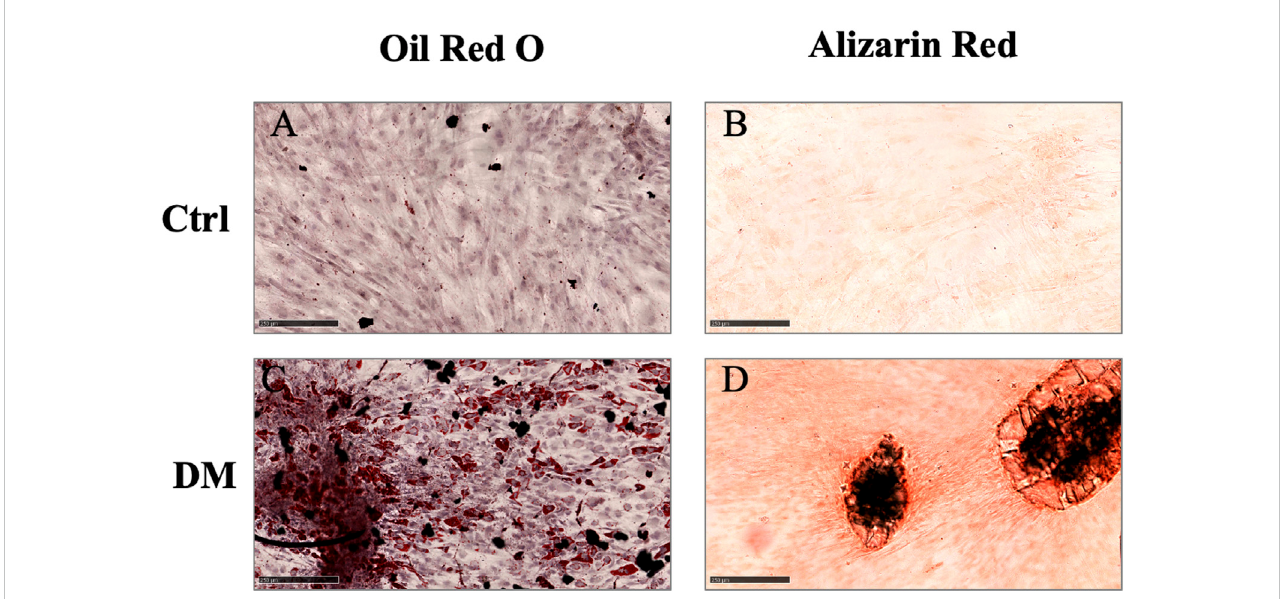
FIGURE 3 Multilineage differentiation assay. (A – C) Oil Red O staining of cells differentiated toward adipocytes (DM), compared to control cells cultured for the same days in DMEM with 10% FBS (Ctrl); (B – D) Alizarin Red staining of cells differentiated toward osteoblasts (DM), compared to control cells cultured for the same days in DMEM with 10% FBS (Ctrl). Scale bars = 250 µm.